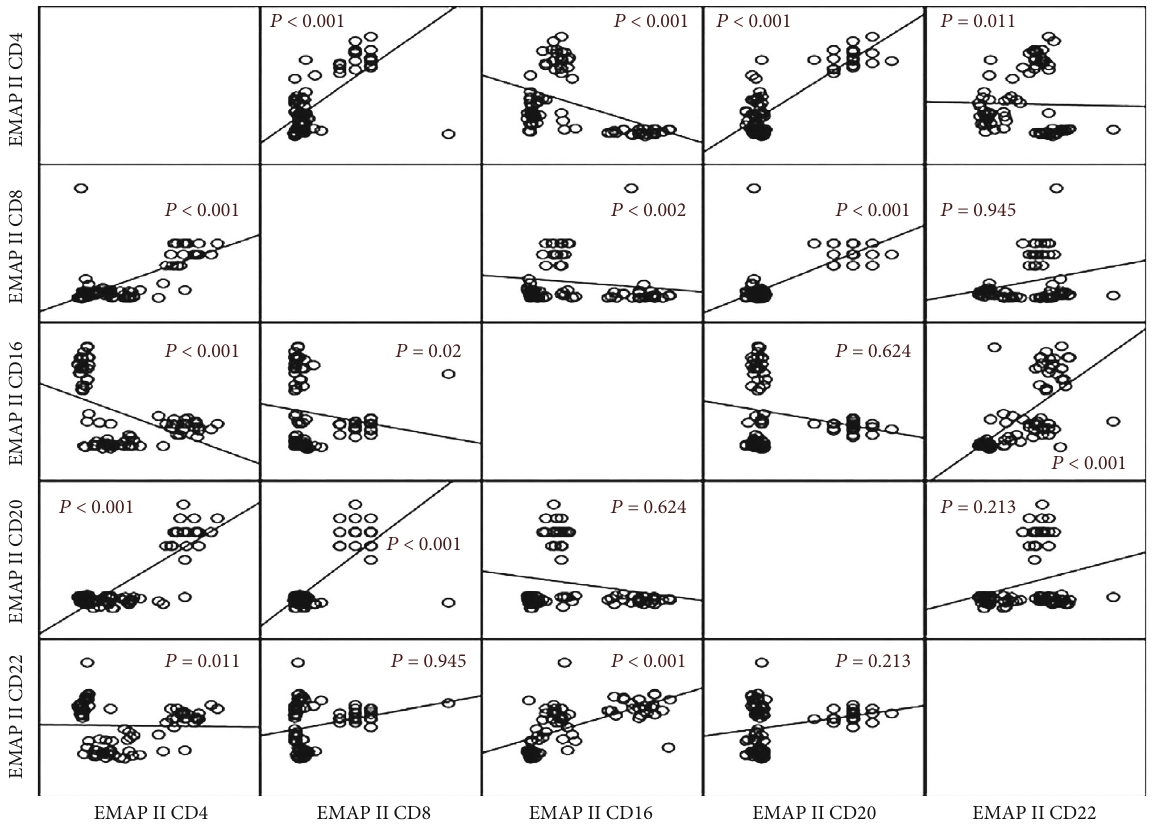
Figure 4: Correlations between EMAP II percentages on peripheral blood cells in NHL patients. P values are